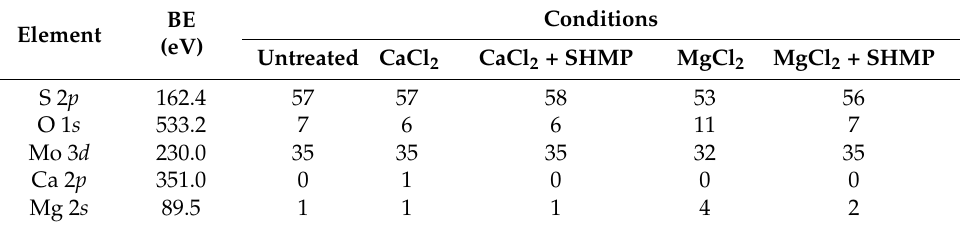
Figure 10. XPS survey spectra of MoS 2 treated in different solution at pH 10. Table 3. Elemental quantification (at %) of MoS 2